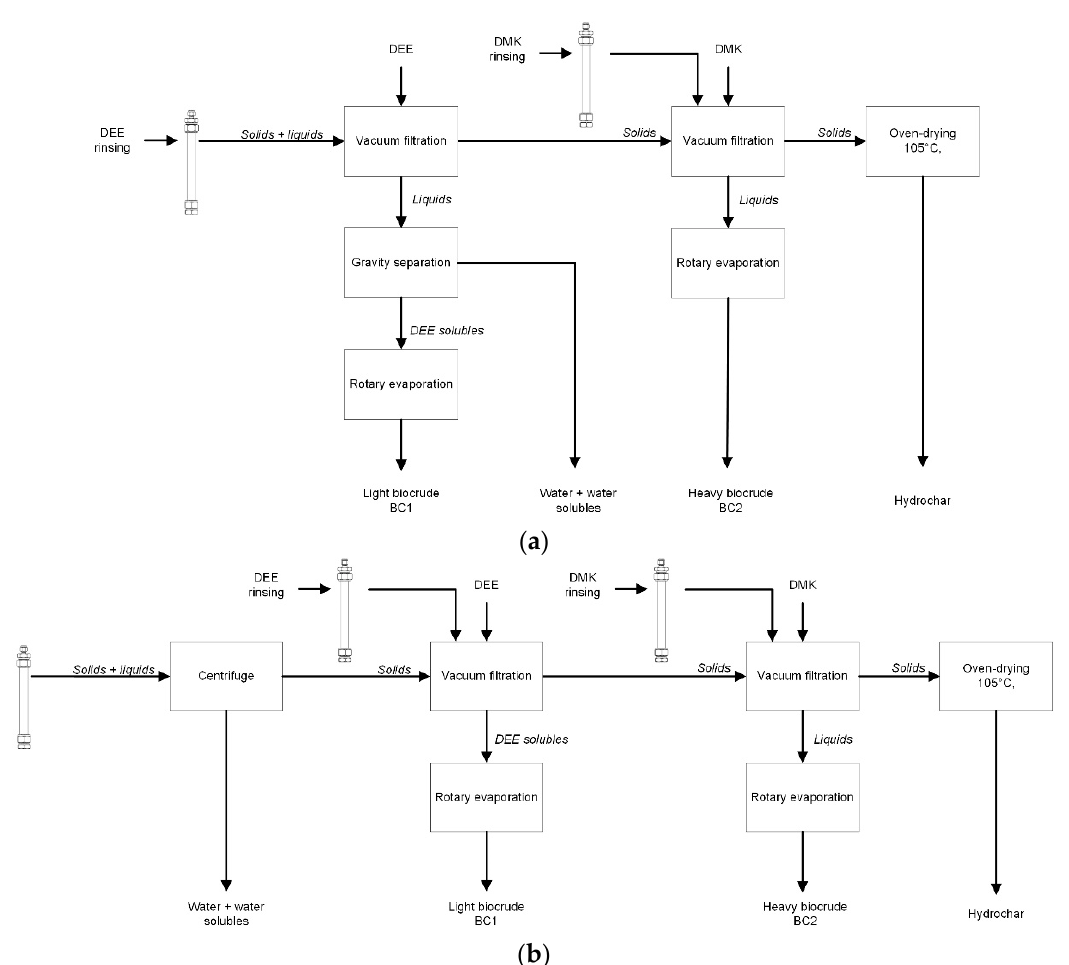
Figure 1. Scheme of Procedure 1 ( a ) and 2 ( b ) for products collection.